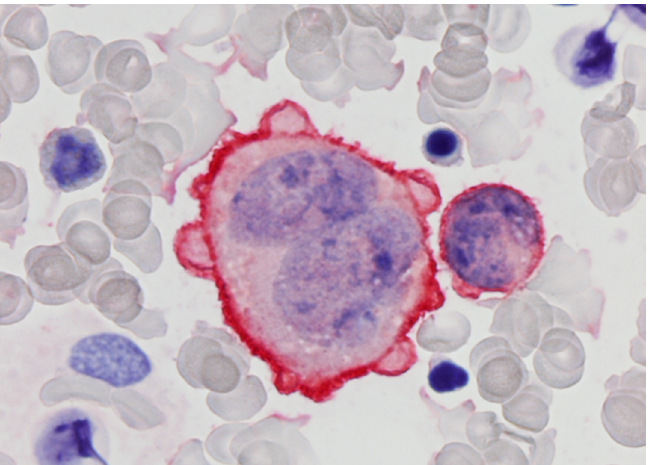
Figure 3. Anaplastic large cell lymphoma cells in bone marrow stained with CD30 using the APAAP method (bone marrow aspirate; haematoxylin counterstain. ×1000).